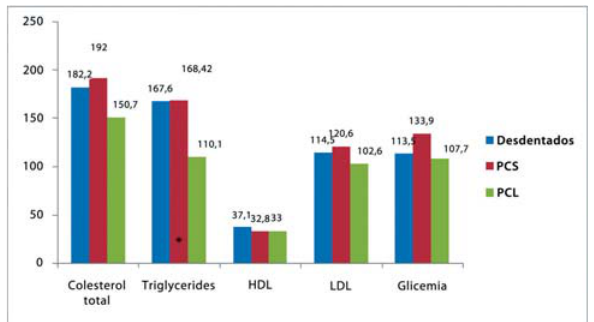
Fig. 4 - Perfil lipídico e glicêmico dos pacientes com doença coronariana, com e sem periodontite crônica leve e grave. HDL = Lipoproteína de alta densidade; LDL = Lipoproteína de baixa densidade; PCS = Periodontite crônica grave; PCL = Periodontite crônica leve. Comparação de médias, via análise de variância (ANOVA), ajustado por idade. Diferença estatisticamente significativa (P £0,05) entre PCL e desdentados. Diferença estatisticamente significativa (P £ 0,05) entre PCS e PCL